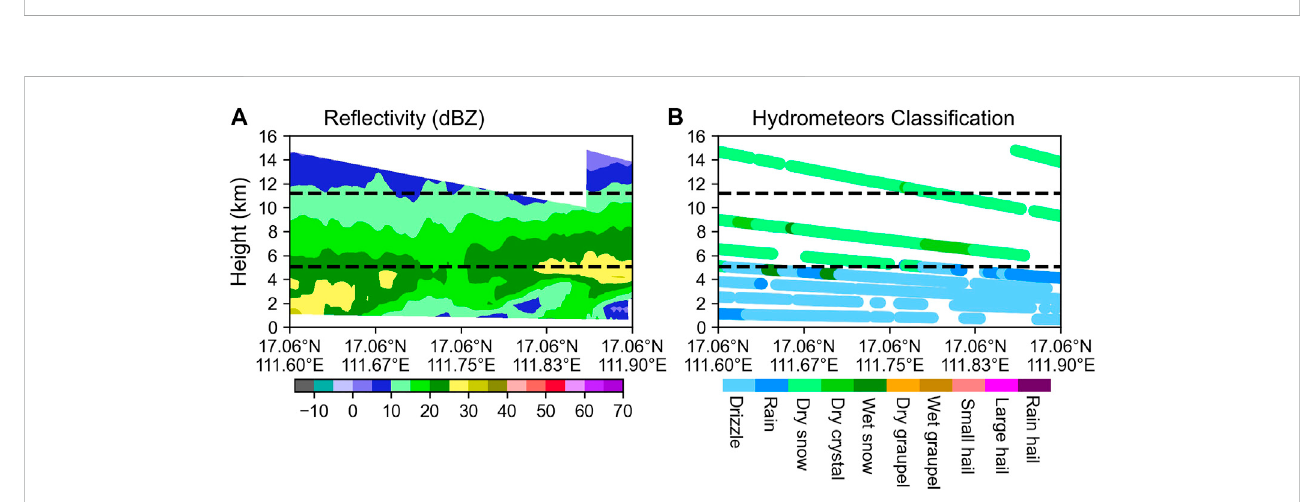
FIGURE 8 Distribution of (A) radarre fl ectivity(units:dBZ)and (B) hydrometeorsat4.3 ° elevation inthestratiformclouds at22:13on16 Octoberalongthesectionin Figure 2E. The black dashed line represents 0 ° C and − 38 ° C isotherms,